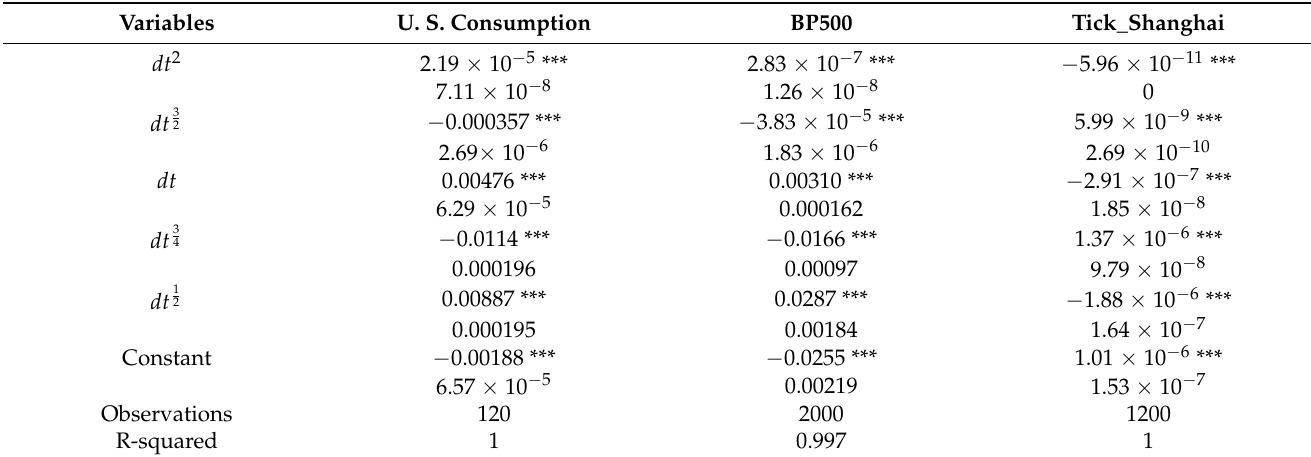
Table 2. Data Decomposition